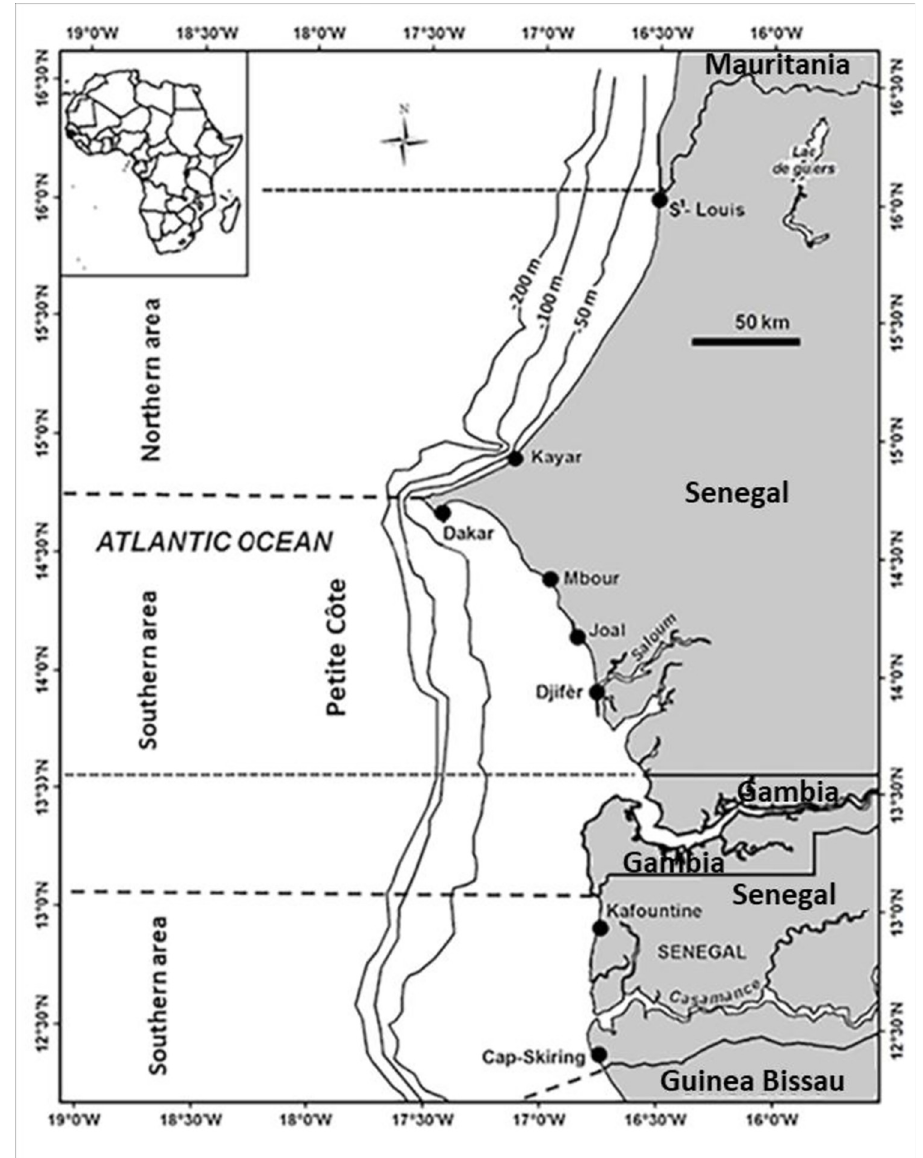
Fig 2. Map of the study area with the localization of sampling stations corresponding to the main landing ports along the Senegal coast. The northern section includes Saint-Louis, Kayar, and Yoff; the southern section includes the “Petite coˆte” (Hann, Mbour, and Joal) and Casamance (Kafountine).